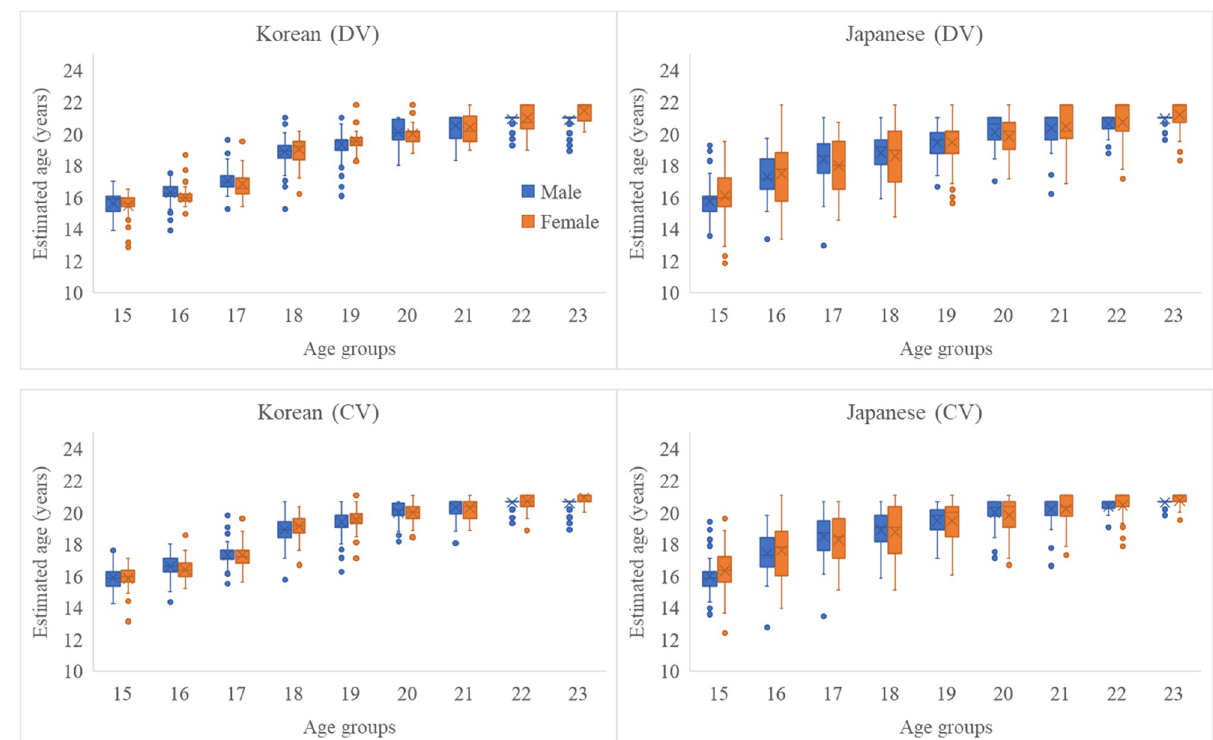
Fig 2. Box plots for comparison between chronological and estimated ages. The age was estimated based on the maturity of M2s and M3s in both jaws, and analyses were performed based on the assumption that the variables were discrete (top) and continuous (bottom). Blue represents male, and orange represents female.